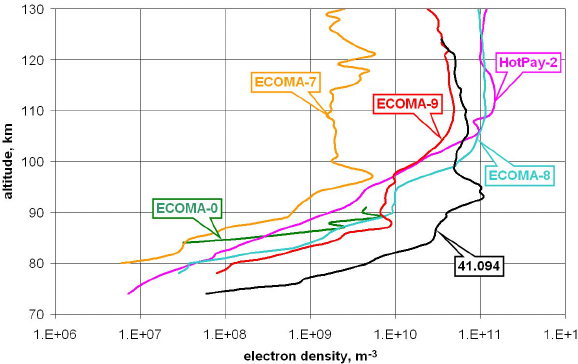
Figure 2 Night time electron density profiles of rocket flights which carried particle detectors and positive ion probes. The profile ECOMA-7 is the lowest ever measured at auroral latitudes. Fig. 2. Night time electron density profiles of rocket flights which carried particle detectors and positive ion probes. The profile ECOMA-7 is the lowest ever measured at auroral